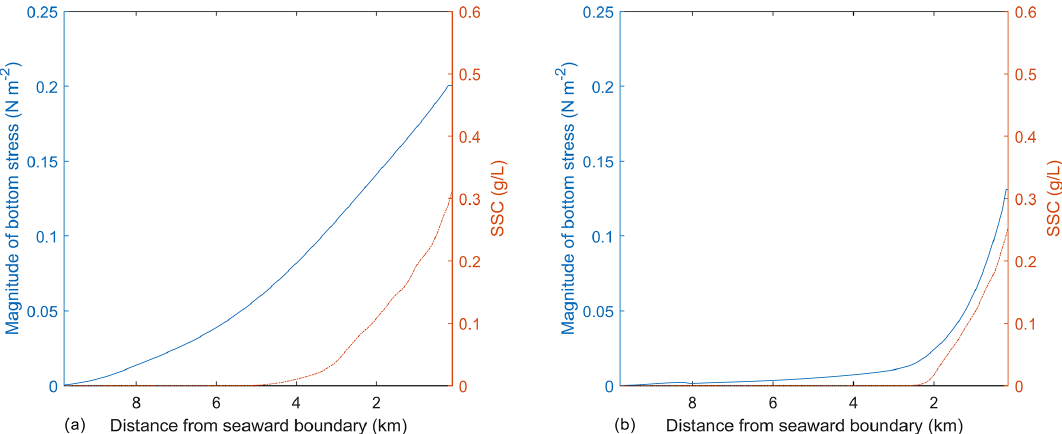
Figure 7. Magnitude of bottom stress (a) and depth-integrated SSC (b) at the end of the simulation plotted along the y axis of the idealized domain at two locations, including one outside ( x = 1 . 8km; panel a ) and one inside the SAV bed ( x = 4 . 8km, panel b